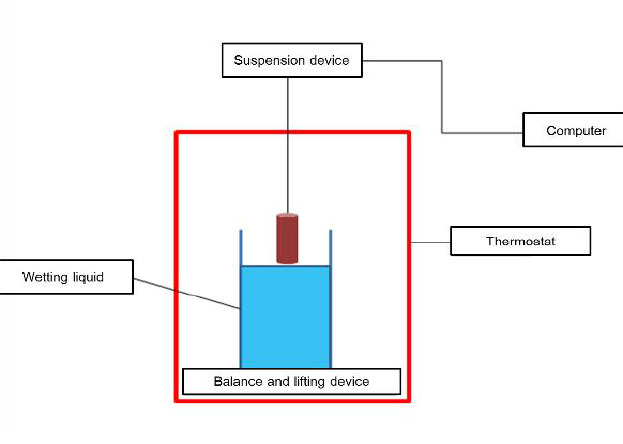
Figure 1—apparatus of spontaneous imbibition.